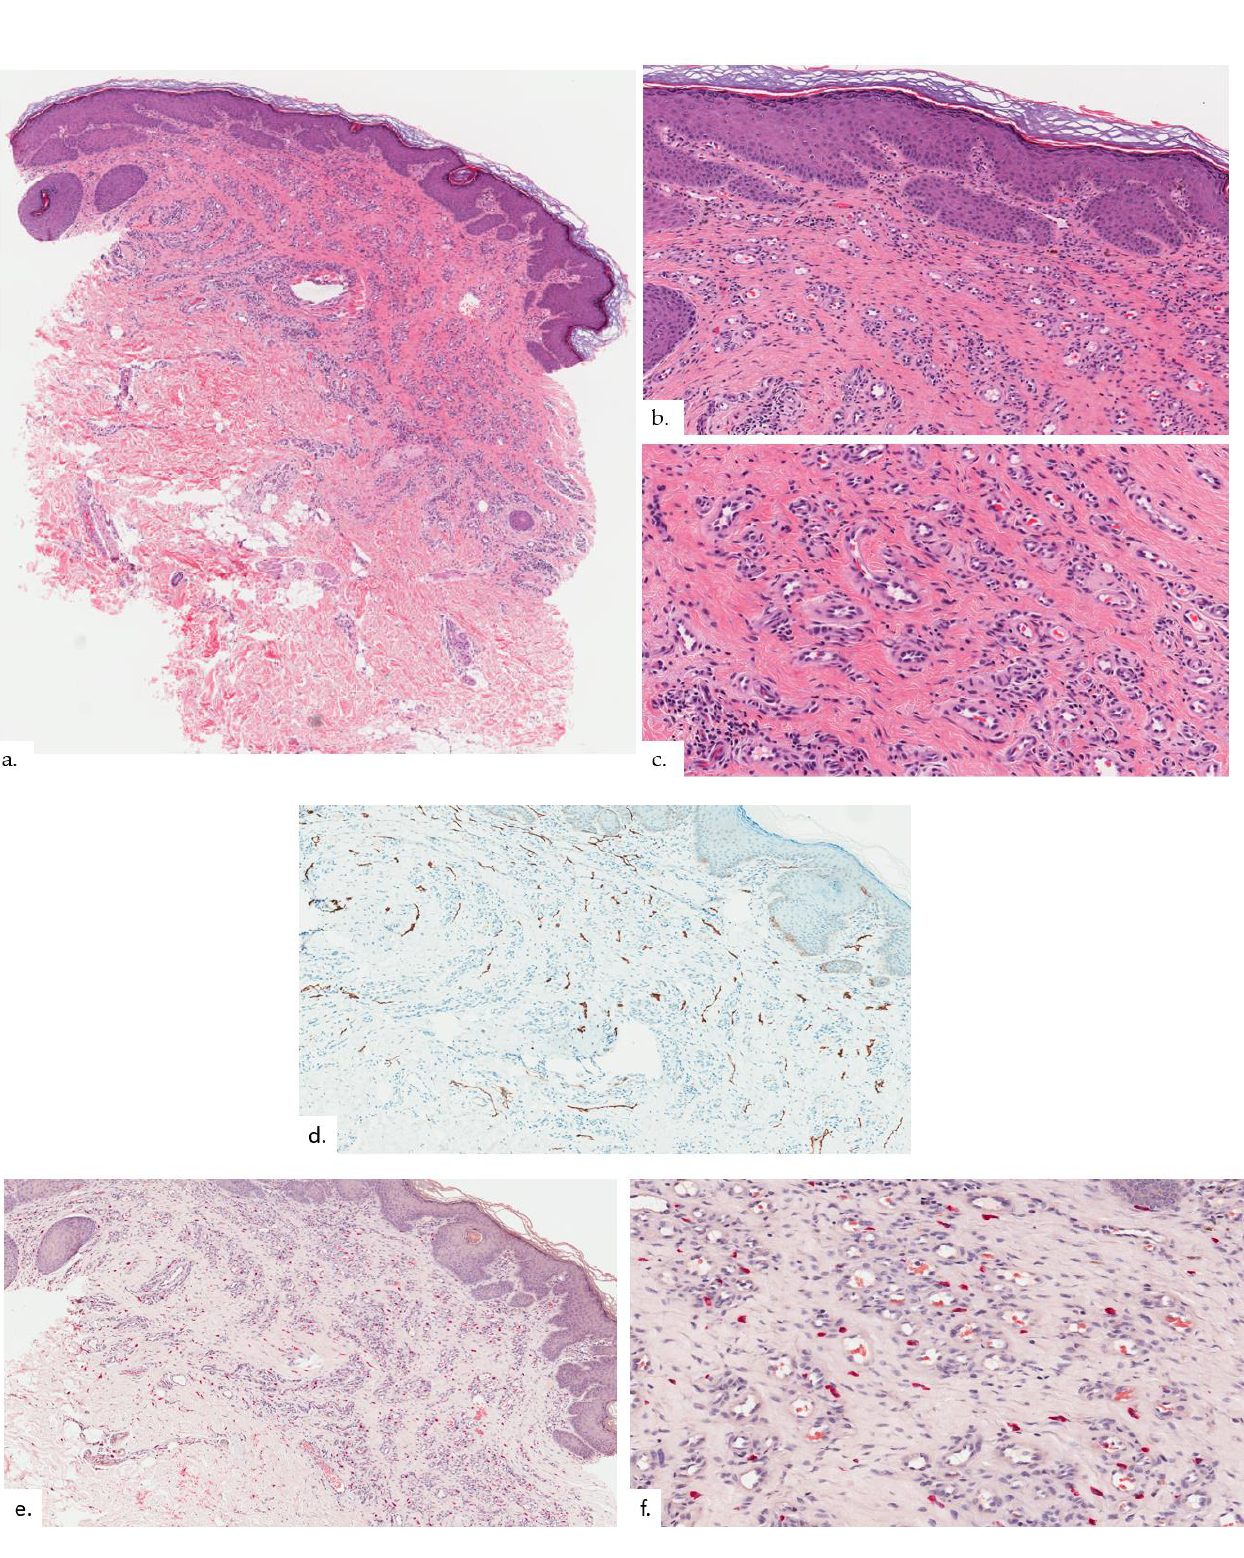
Figure 2. Patient 1. ( a , b ) There was hyperkeratosis with psoriasiform hyperplasia; ( c ) there was prominent vascular proliferation present in the upper to the mid dermis, consisting of proliferation of capillary type vessels without any overt endothelial cell atypia; ( d ) a modest increase in lymphatic channels was highlighted on podoplanin; ( e , f ) MC density was increased in proportion with vasoproliferation as seen on CAE stain.